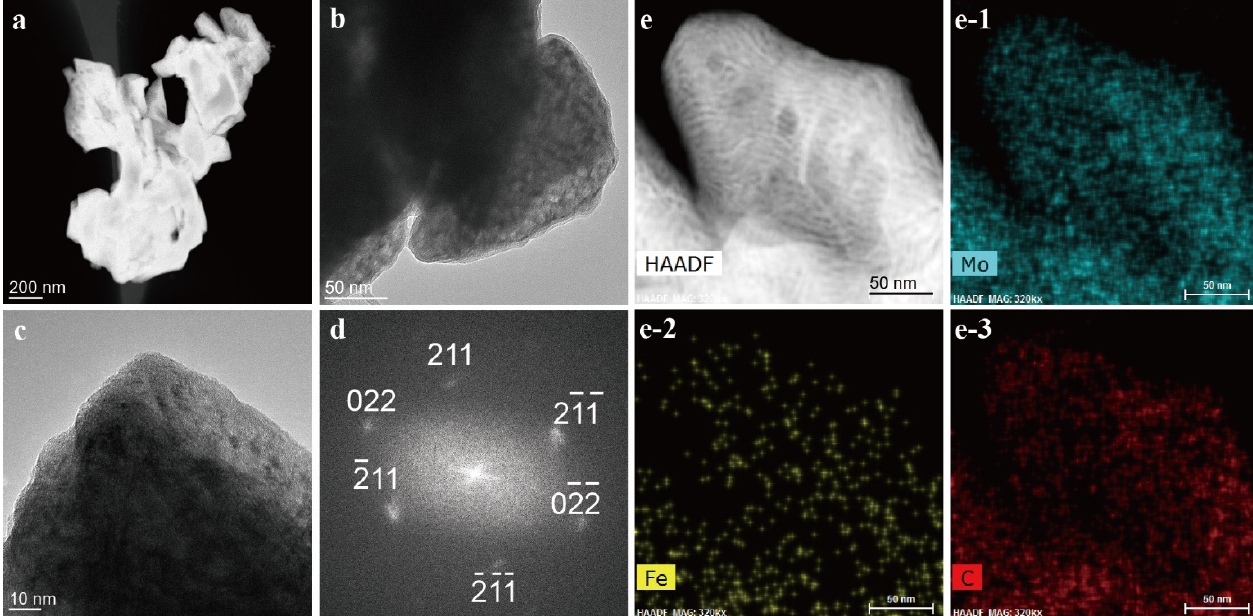
Figure 3. ( a ) High-angle annular dark-field scanning transmission electron microscopy (STEM-HAADF) image, and transmission electron microscopy (TEM) images ( b , c ) of the fresh 1.5Fe-Mo 2 C-550 catalyst, ( d ) corresponding fast Fourier transform (FFT) image confirming the presence of β -Mo 2 C, ( e ) STEM-HAADF and corresponding energy-dispersive X-ray spectroscopy (EDX) element mapping of ( e - 1 ) Mo, ( e - 2 ) Fe, ( e - 3 ) C of fresh catalyst 1.5Fe-Mo 2 C-550.